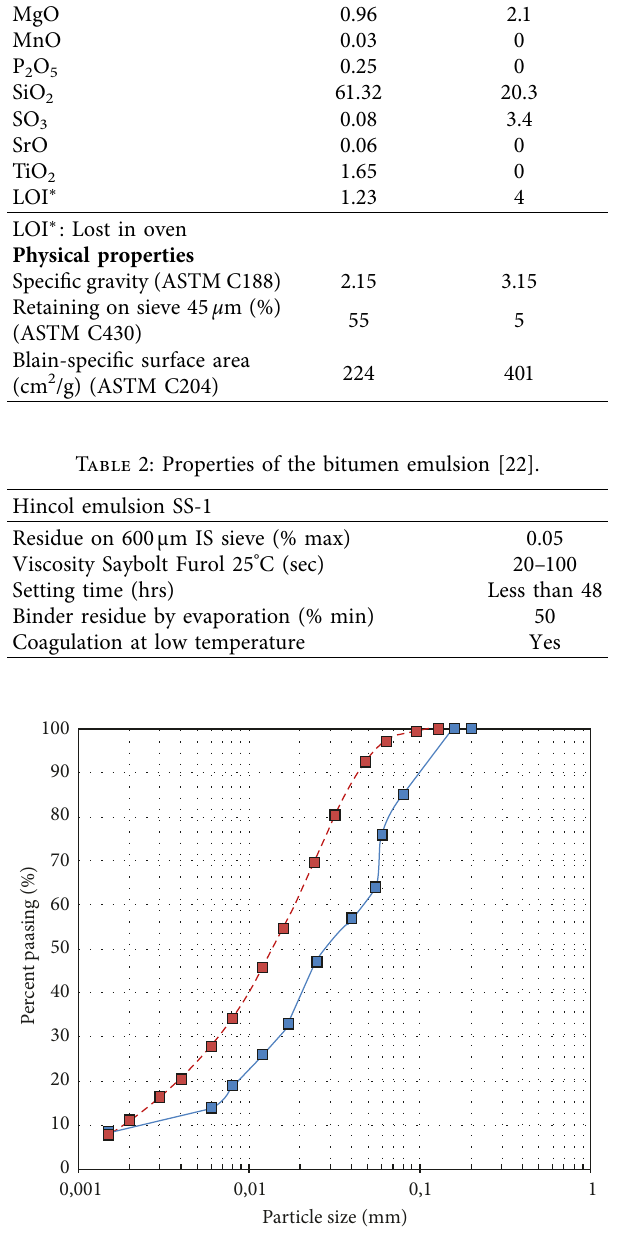
Figure 1: Particle size distribution of fly ash [23,